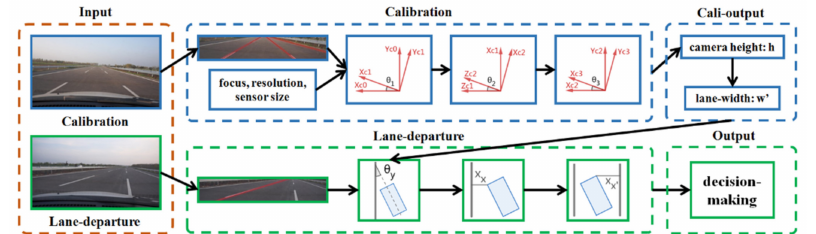
Figure 1. Overview of our proposed method. First, calibration with three parallel and equally spaced lines on the ground is applied to estimate the three angles of rotation for the transformation from the camera coordinate system to the world coordinate system. Next, camera height is calculated, then lane-width can be calculated from the camera height. After calibration, lane departure warning is done by estimating the distance between the lane-marking and the vehicle as well as the yaw angle of the vehicle to the lane with only one of the two lane-markings. Finally, decision is made using the estimated distance and